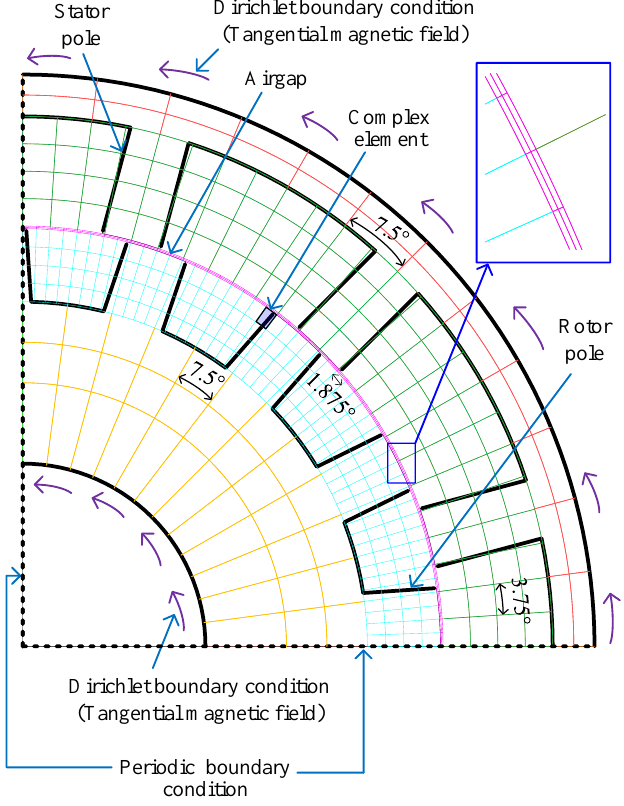
Figure 2. An example reluctance mesh for 12/16 SRM [18].